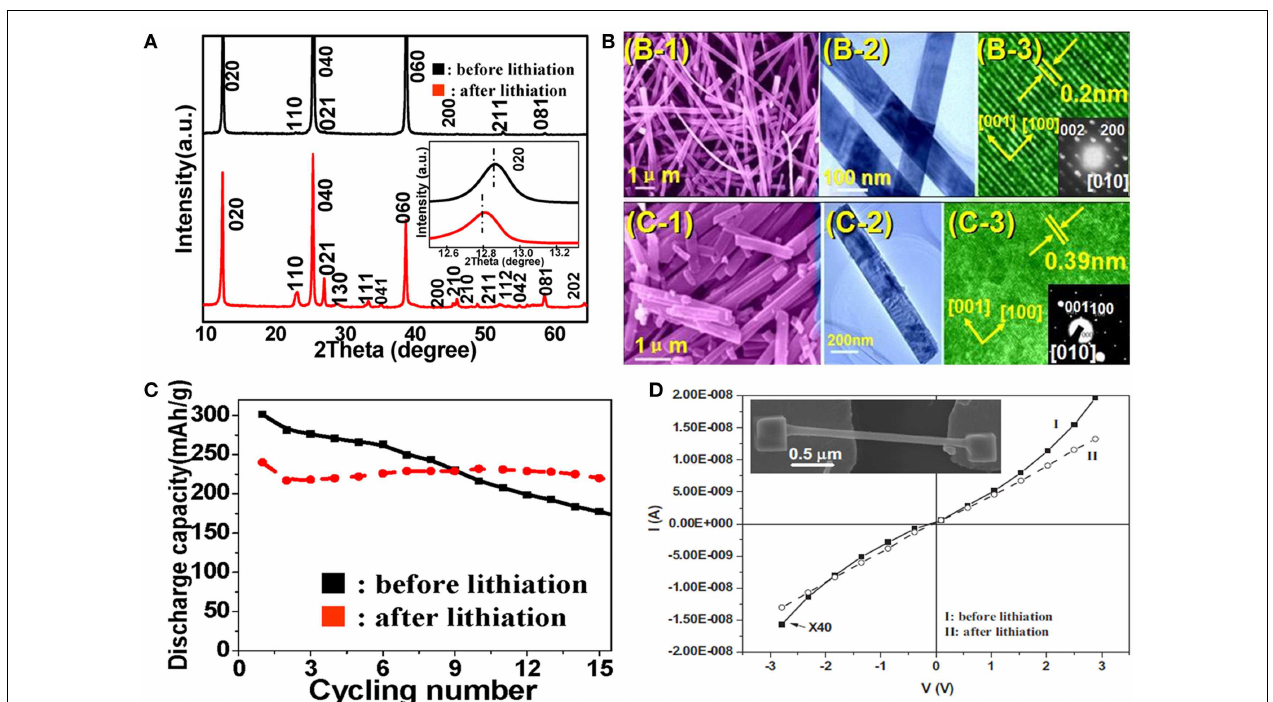
selected area electron diffraction (SAED) patterns. (C) The cycling performance of the MoO 3 nanobelts before and after lithiation. (D) Transport measurements of single MoO 3 nanobelt before and after lithiation. Reprinted with permission from Mai et al. (2007). Copyright 2007 JohnWiley & Sons,